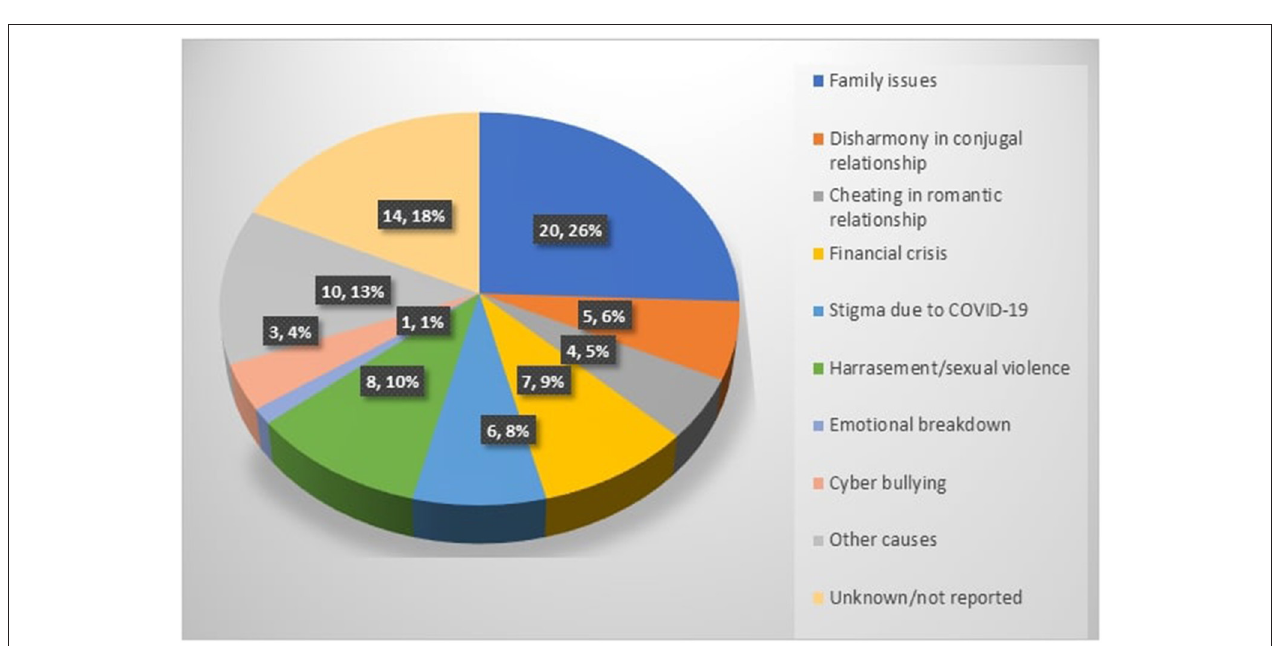
FIGURE 1 | Flow chart showing strategy adapted for one search term (Mental stress and COVID-19) in one Bangla newspaper (Daily Kaler Kantho).